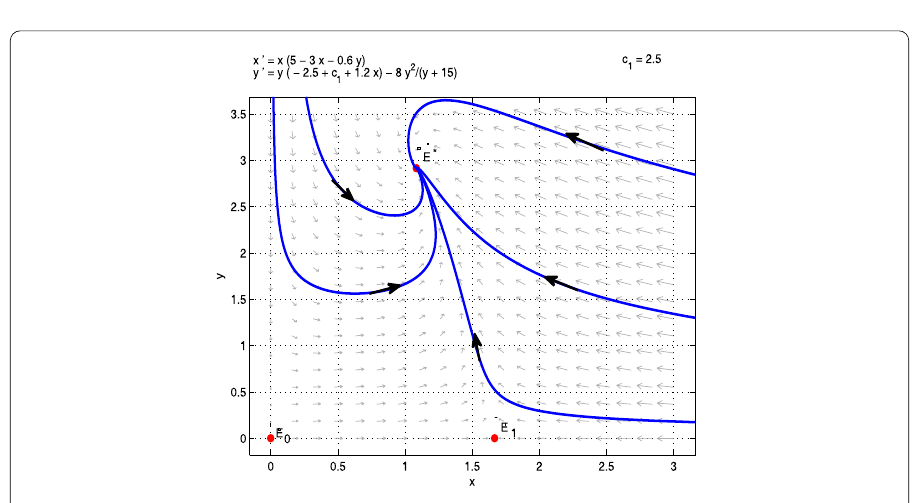
Figure 4 Dynamic behaviors of system (4.2) if c 1 =